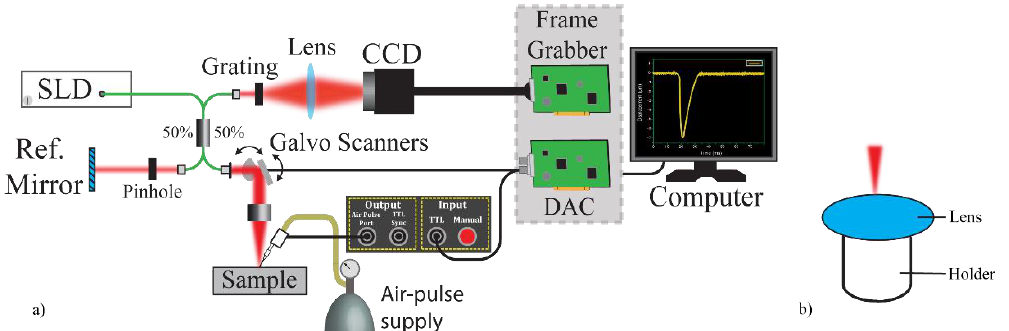
Figure 1. Schematic of the OCE system. ( a ) A micro-air pulse is co-aligned with an SD-OCT system to detect air pulse- induced elastic waves on the surface of the excised porcine lens and ( b ) the sample holder.